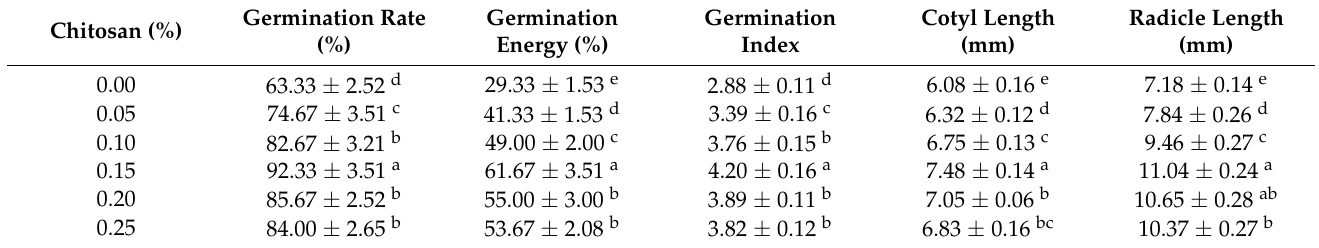
Table 2. Influences of chitosan soaking on seed germination, cotyl length, and radicle length of P. grandiflorus